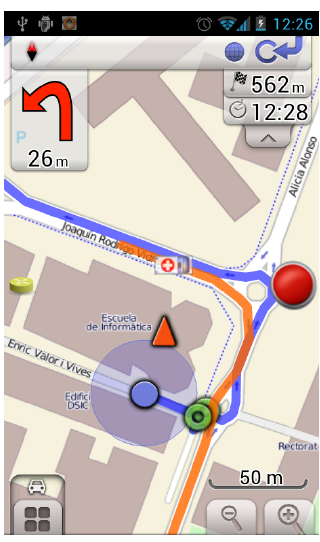
Figure 11: Ambulance warning